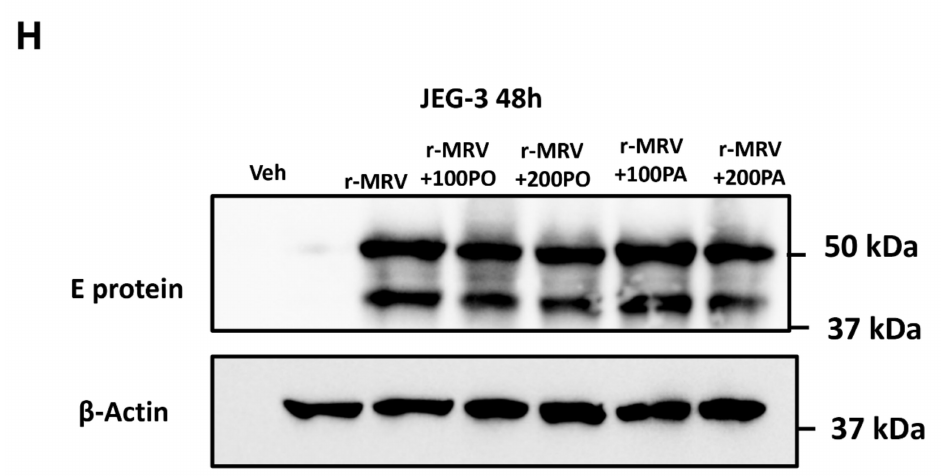
Figure 3. Treatment of the placental trophoblasts with palmitoleate after Zika virus (ZIKV) infection interferes with viral replication. The presence of the viral envelope RNA copy number in the cell culture supernatant of both ( A ) JAR and ( B ) HTR-8 cells infected with 0.1 and 1.0 MOI of ZIKV MR766 strain 72 h and 96 hpi, respectively. When MRV-infected cells were treated with palmitoleate (100–200 µ M), there was significant reduction in the viral envelope RNA copy number in the cell culture supernatant with both 0.1 and 1 MOI in JAR cells and with 1 MOI in HTR-8 cells ( A , B ). The presence of viral envelope RNA copy number both in JAR (C) and HTR-8 ( D ) cell lysate infected with 0.1 and 1.0 MOI of ZIKV MR766 strain 72 and 96 hpi, respectively. When the infected cells were treated with 100–200 µ M of palmitoleate, there was a trend showing reduced viral envelope RNA per microgram of total RNA in both JAR cell lysate ( C ) and HTR-8 cell lysates ( D ). Data represent mean ± SEM, n = 3. # p < 0.05 compared to ZIKV-infected cells. ( E – G ) Viral E protein staining in JEG cells infected with 0.1 MOI r-MRV and in cells treated with 100 or 200 µ M palmitoleate, 48 hpi. ( E ) ZIKV- infected cells show green fluorescence indicating presence of viral E protein. ( F ) ZIKV-infected JEG-3 cells treated with 200 µ M palmitoleate and show a reduction in the intensity of viral E protein staining. ( G ) Infected JEG-3 cells treated with 100–200 µ M palmitate showed increased intensity of viral E protein staining. Nuclei were stained with DAPI. ( H ) Immunoblot analysis showed a dramatic increase in viral E protein expression with ZIKV infection in JEG-3 cells compared to vehicle uninfected cells. Treatment of 200 µ M palmitoleate to ZIKV-infected cells showed reduced viral E protein expression compared to the ZIKV-infected cells